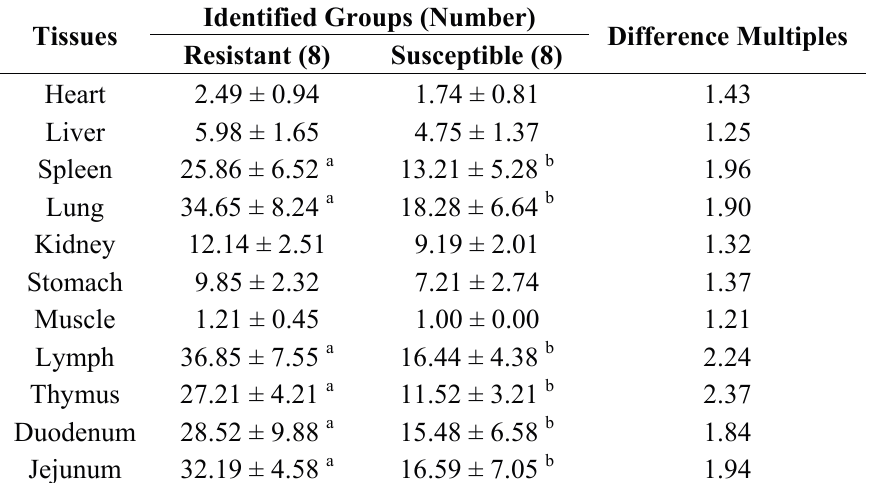
Table 1. Analysis of the TAP1 gene mRNA expression levels in 11 tissues of the E. coli F18-resistant and E. coli